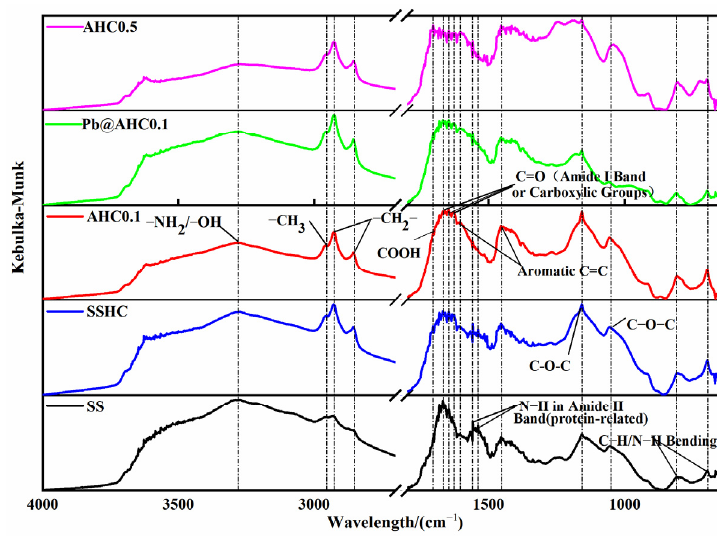
Figure 1. DRIFT spectra of SS, SS-derived hydrochars, and Pb@AHC0.1.